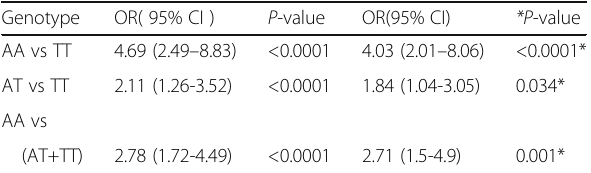
Table 3 Association of FTO variant (rs9939609) with T2DM